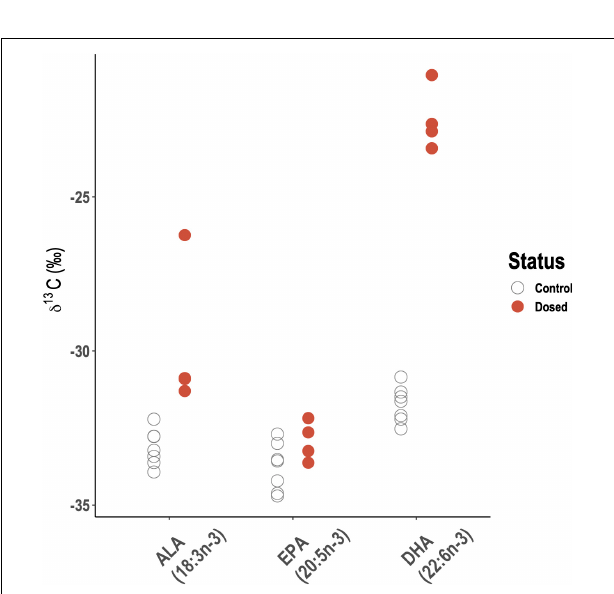
FIGURE 6 | Carbon stable isotope ( δ 13 C) values for α -linolenic acid (ALA), eicosapentaenoic acid (EPA), and docosahexaenoic acid (DHA) for Blue Tit nestlings dosed with 13 C-enriched ALA (filled circles) and control nestlings (open circles). All data is expressed versus Vienna Pee Dee